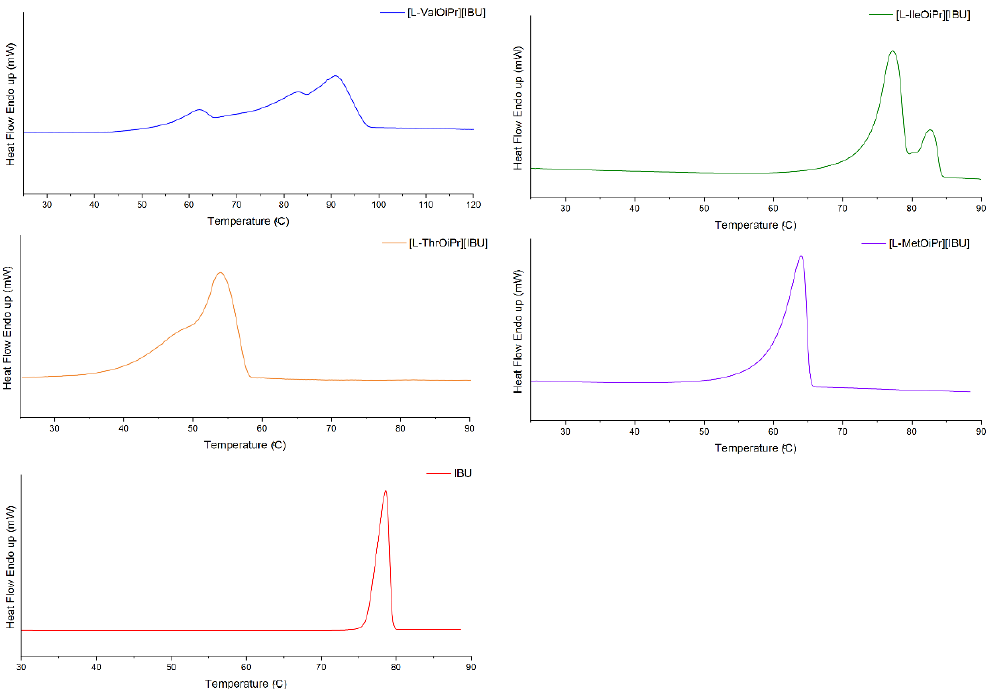
Figure 2. The DSC curves of first heating cycle of ibuprofen and ibuprofen salts: [L − ValOiPr][IBU] (blue), [L − IleOiPr][IBU] (green), [L − ThrOiPr][IBU] (orange), [L − MetOiPr][IBU] (purple), IBU (red).